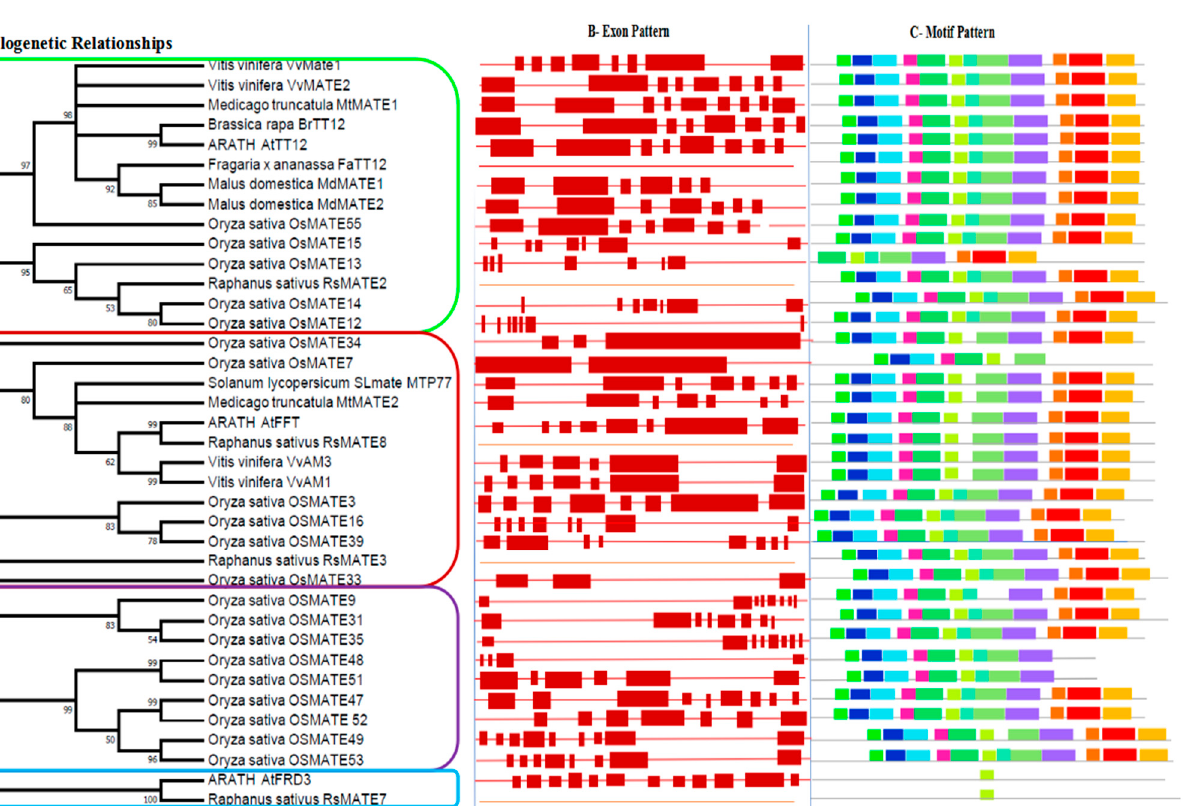
Figure 3. Phylogenetic relationships and domain compositions of the MATE proteins. ( A ) The unrooted phylogenetic tree was constructed with 1000 bootstrap replicates based on multiple alignments of 38 MATE amino acid sequences. The four major subgroups are marked with a different colored line. Each color represents one cluster (CL): cluster1 (CL1), blue color; cluster2 (CL2), green color; cluster3 (CL3), red color; cluster4 (CL4), violet color. ( B ) Exon pattern, red boxes represent exons while lines represent introns. ( C ) The conserved motifs in the MATE proteins were identified using MEME, gray lines represent the non-conserved sequences. Each motif is indicated by a colored box numbered at the bottom. The length of the motifs in each protein is exhibited proportionally. Twelve motifs are illustrated using different colored boxes to get more information about the motif sequence, refer to Table S3.